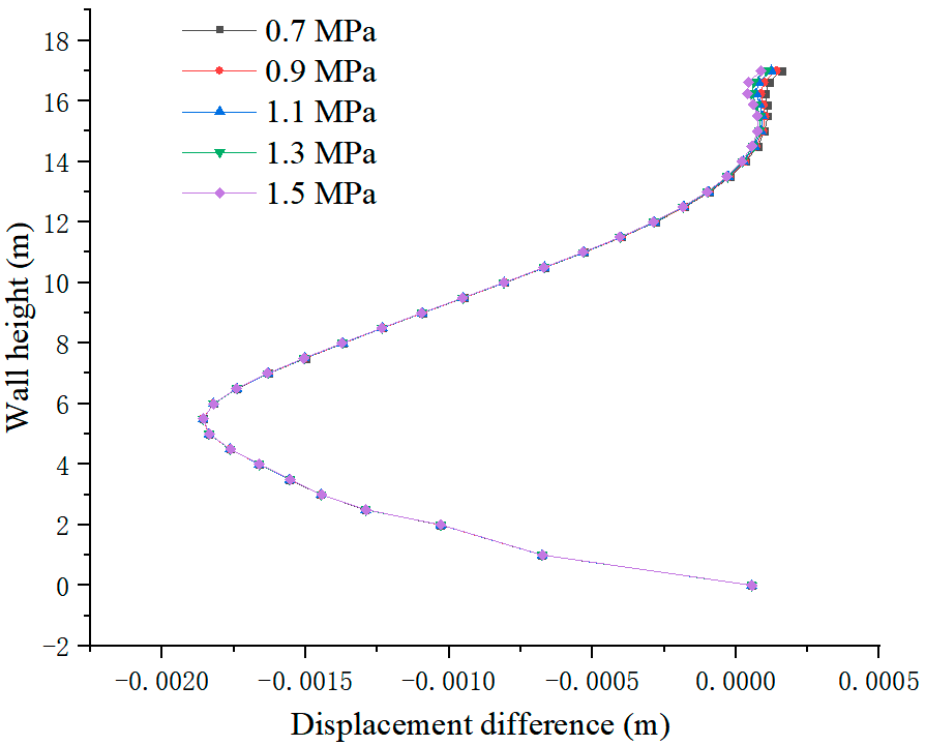
Figure 10. Distribution of the displacement difference along the anti-seepage wall under different load amplitudes.